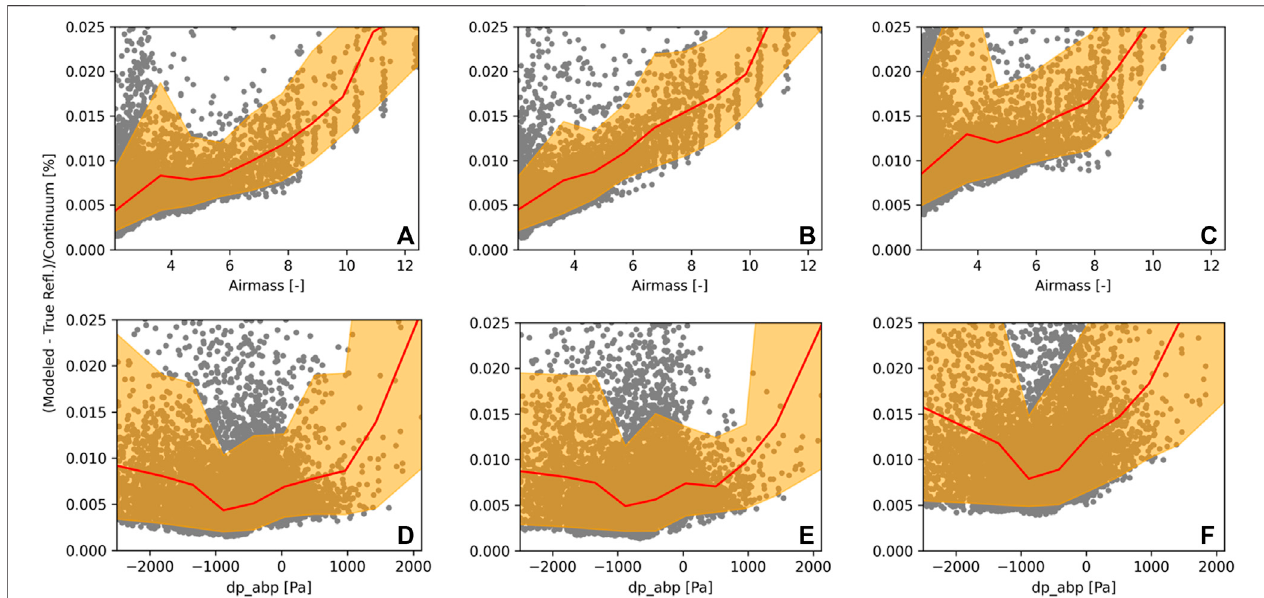
FIGURE 6 | Reconstruction error in percent relative to continuum with respect to airmass for the (A) O2A-band, (B) WCO2-band, (C) SCO2-band as well as dp_abpforthe (D) O2A-band, (E) WCO2-band,and (F) SCO2-band. Themeanisshowninred,the5thand95thpercentileinorange,andtheerrorofindividualspectra with grey